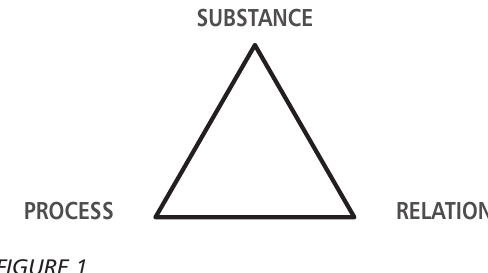
FIGURE 1 Conflict Management Progress